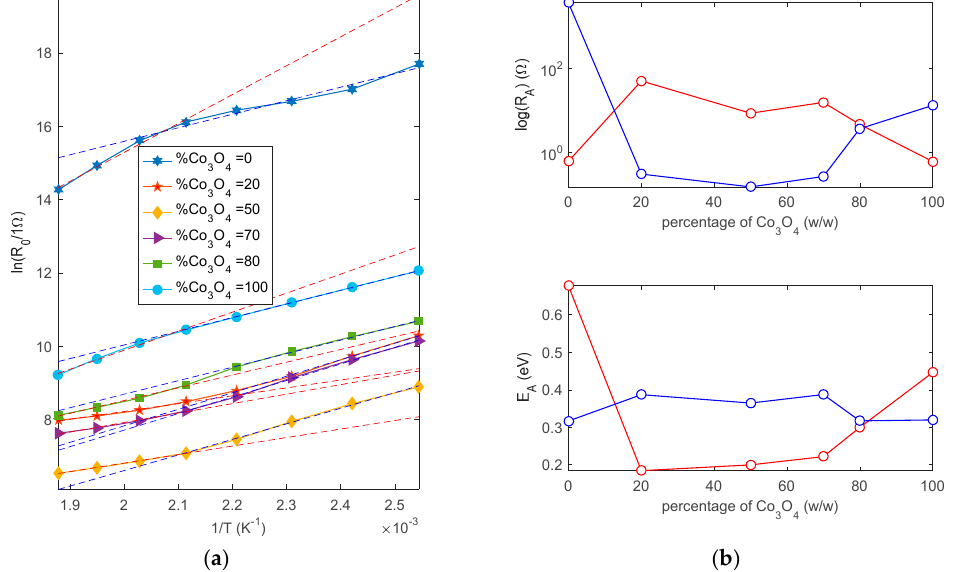
Figure 9. (a) ln(R 0 ) vs. 1/T, markers-experimental values, dashed red lines-linear fitting in the high temperature range (200 °C–260 °C), blue dashed lines—linear fitting in the low temperature range (120 °C–200 °C). (b) Estimated parameters E A , R A from the two fittings (see Equations (5), (6) and (14)). Linear fitting performed according to the following relationship ln ( R 0 ) = ln ( R A ) + E A lines—linear fitting in the high temperature range (200 °C–260 °C), blue lines—linear fitting in the low temperature range (120 °C–200 °C).